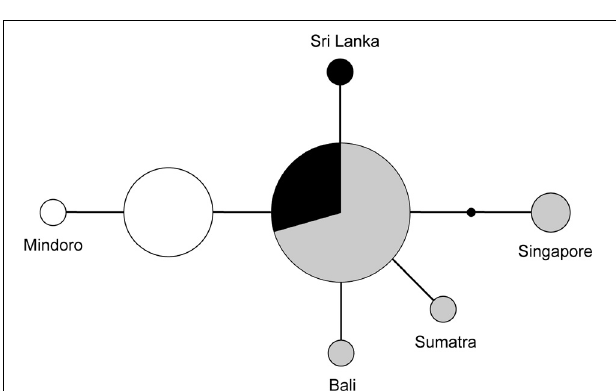
FIGURE 4 | Unrooted network of the nuclear FIB7 alleles ( n = 34). Sizes of the circles represent the number of times an allele was observed. The small black dot indicates an unsampled allele. Colors represent geographic origin of the samples: black, India and Sri Lanka; gray, mainland of TE Asia and Sundaland; white,